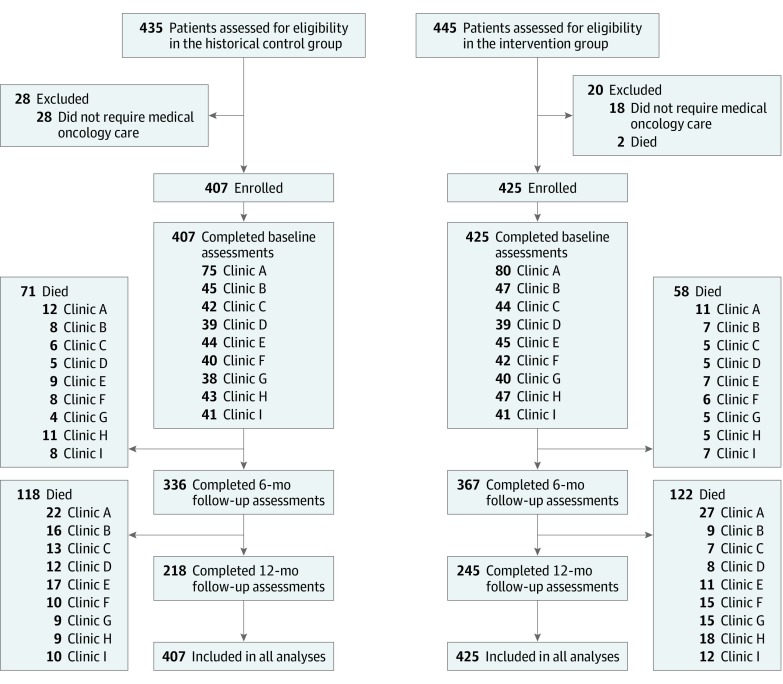
Assessment for Eligibility and Follow-upFlow diagram of patient flow through the study.